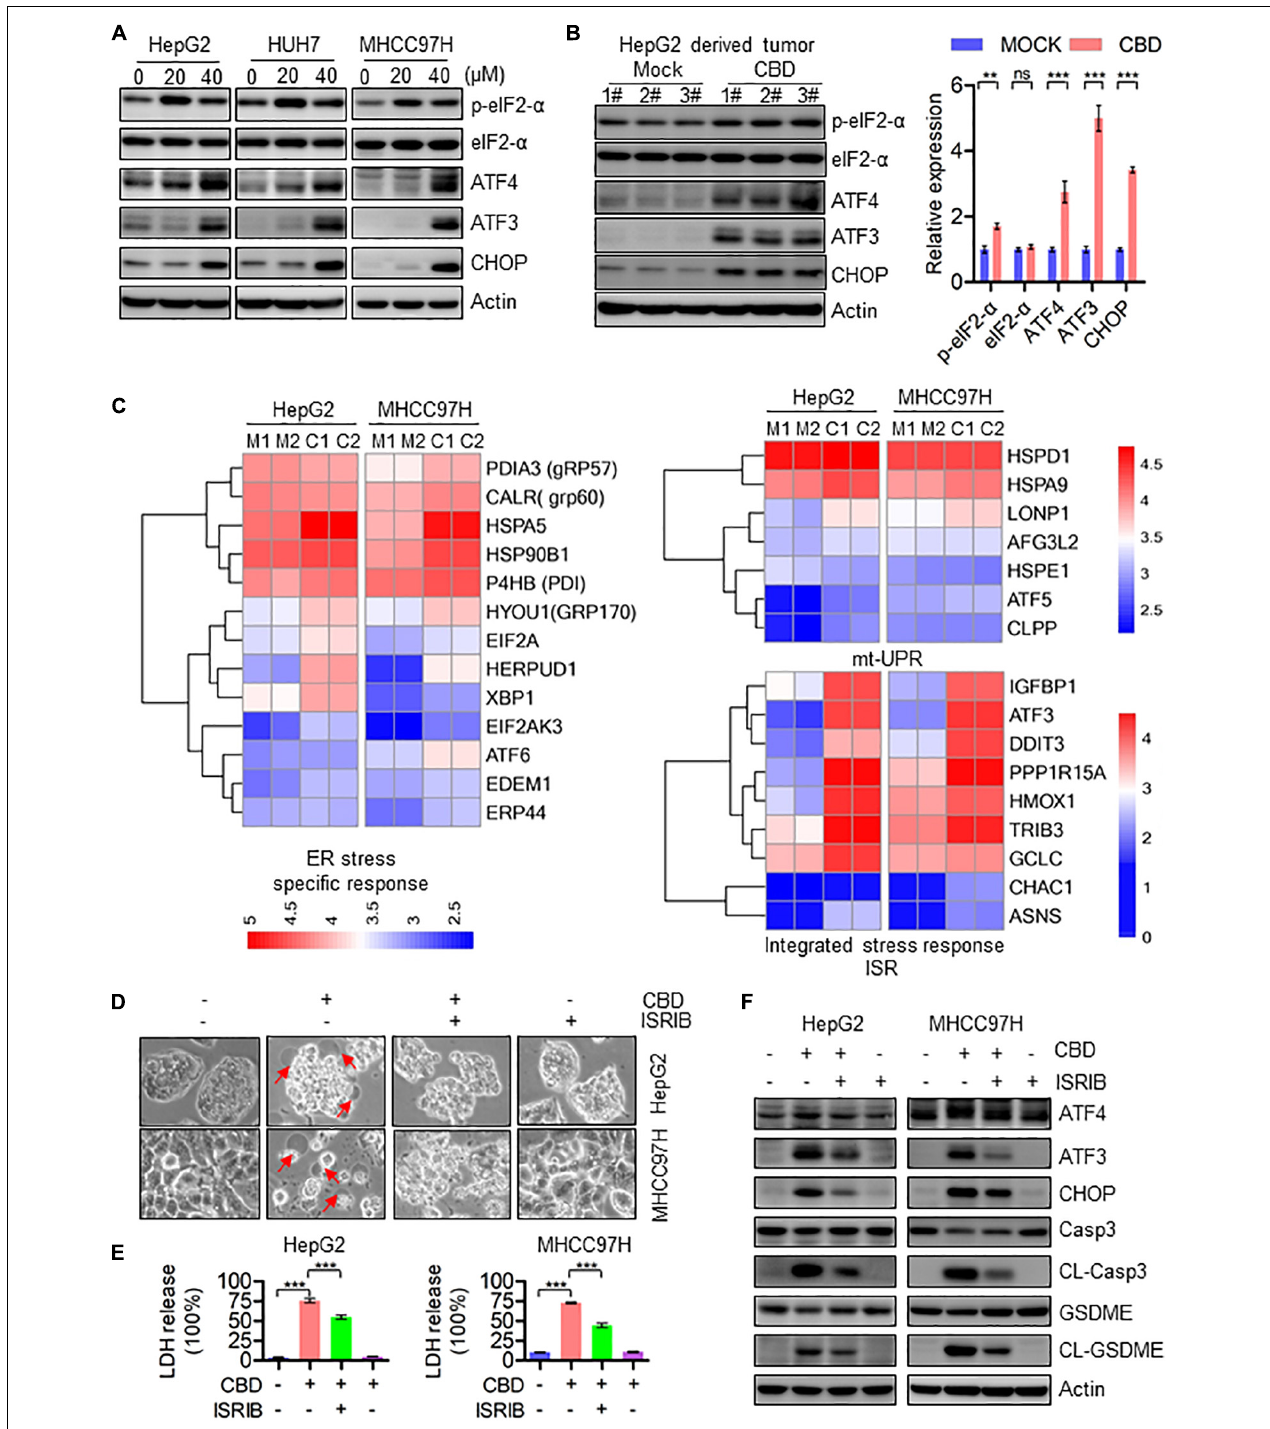
FIGURE 5 | Activation of ATF4/CHOP pathway triggers the GSDME-mediated pyroptosis in response to CBD treatment. (A) Western blot analysis of p-eIF2- α , eIF2- α , ATF4, ATF3, and CHOP in CBD treated HepG2, HUH7, and MHCC97H cells after 24 h. Actin was used as a loading control. (B) Western blot analysis of p-eIF2- α , eIF2- α , ATF4, ATF3, and CHOP in CBD administrated tumor tissues derived from HepG2 cells. Actin was used as a loading control. The graphs represent the mean ± SEM. (C) Heat map analysis from RNA-sequence data in CBD exposed HepG2 and MHCC97H cells for 24 h. (D) Representative morphological changes in CBD-treated HepG2 and MHCC97H cells in the presence or absence of ISRIB. (E) LDH release was performed on CBD-exposed HepG2 and MHCC97H cells with or without ISRIB. (F) Caspase-3, CL-Caspase-3, GSDME, CL-GSDME, ATF4, ATF3, and CHOP were detected by Western blotting in CBD (40 µ M) administrated HepG2 and MHCC97H cells in the presence or absence of ISRIB after 24 h. ** p < 0.01, *** p < 0.001, n.s. represents no significance.